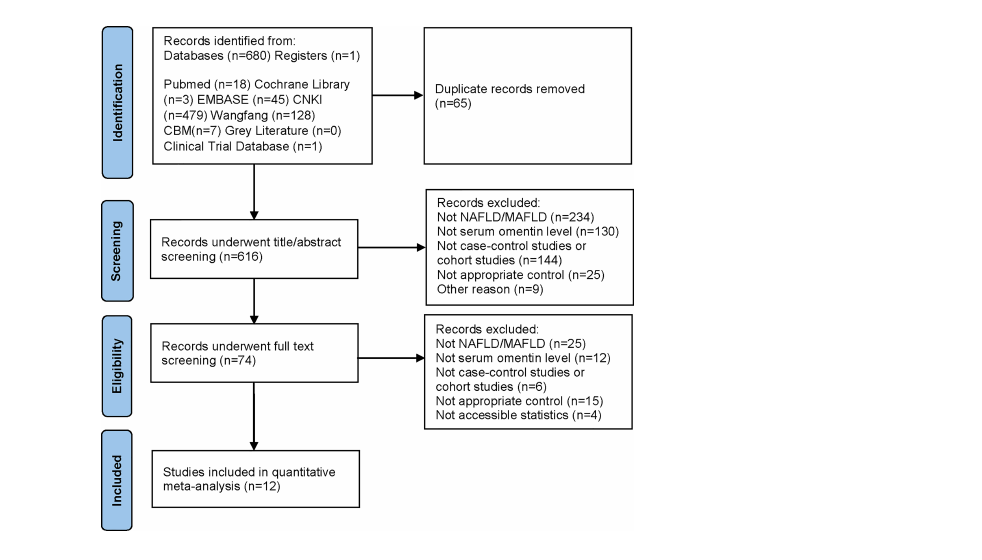
FIGURE 1 PRISMA diagram describing the process of literature